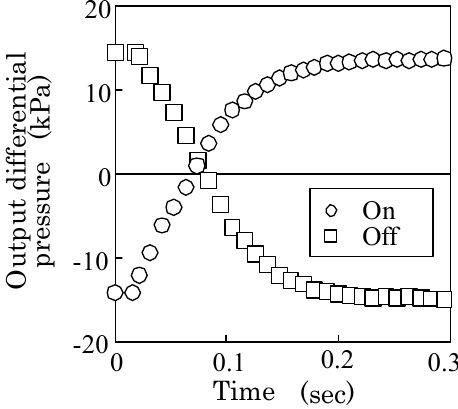
Fig. 11 Step response of improved optical on/off device